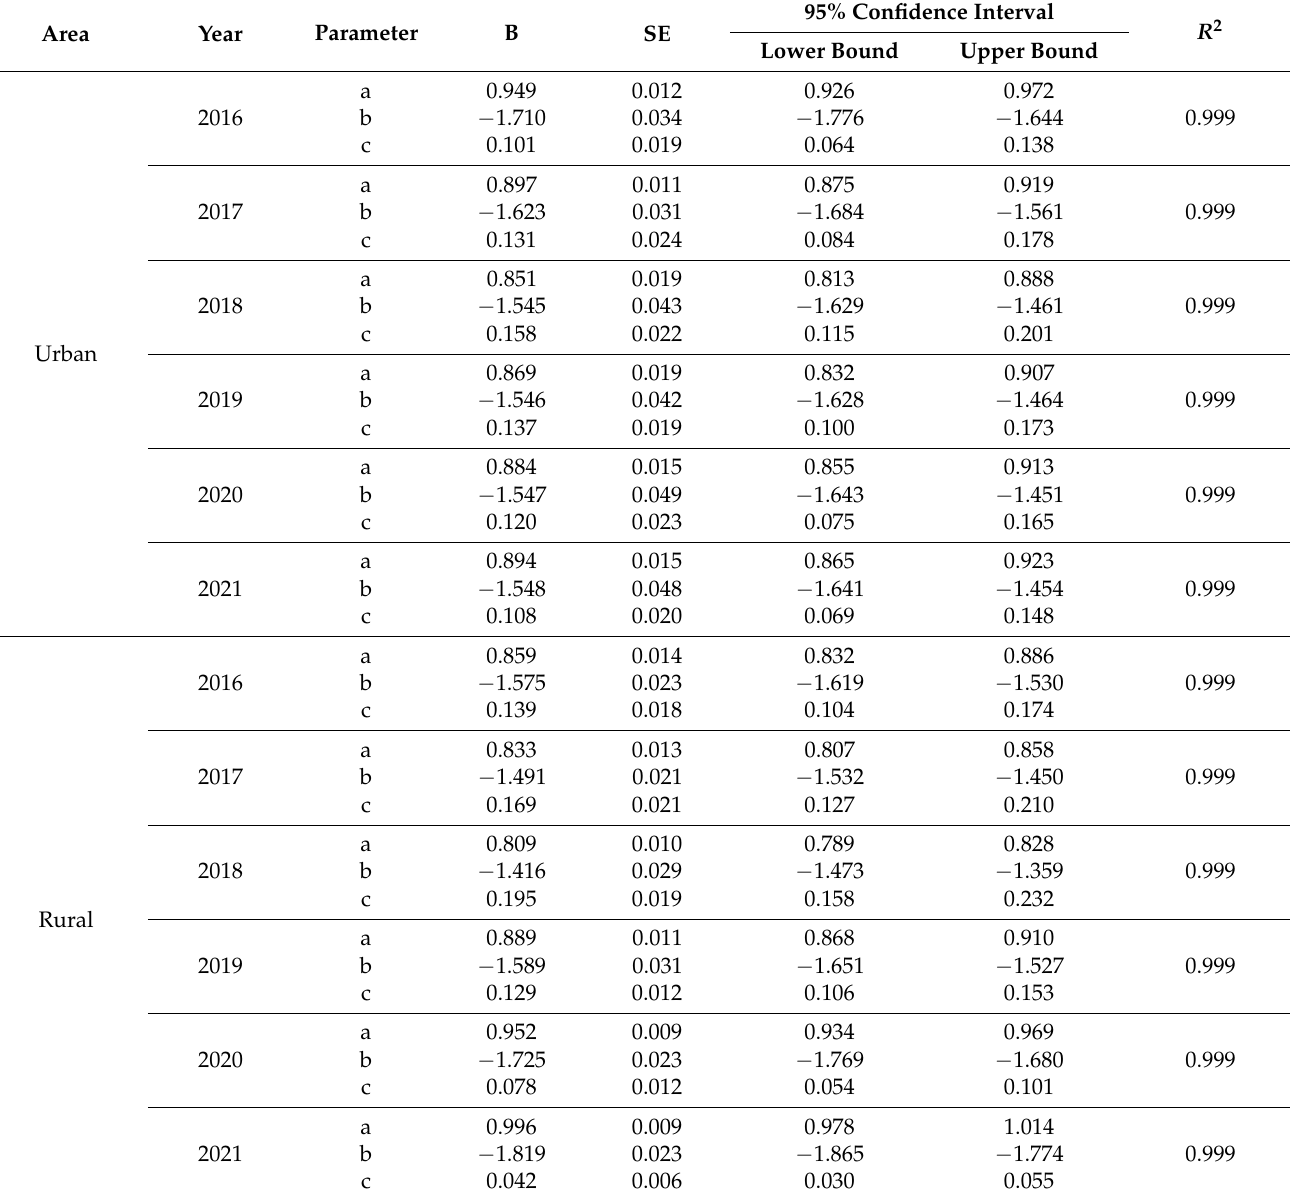
Table A1. Lorenz curve regression